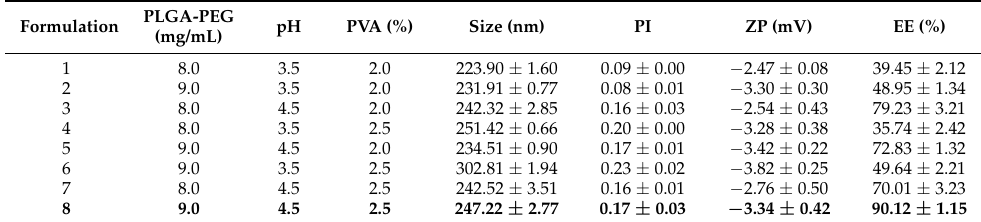
Table 1. PGZ-NPs developed by a factorial design 2 3 . Formulation PLGA-PEG (mg/mL)